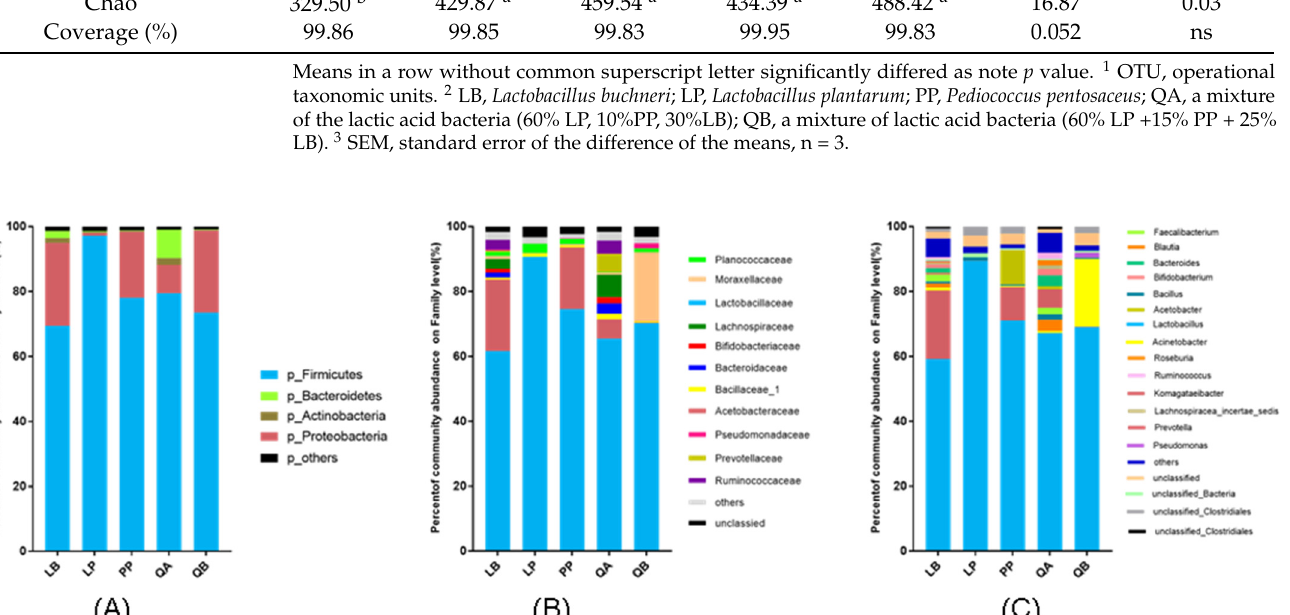
Figure 4. Spearman correlation heatmap of the top tenth of genera and fermentation properties. X and Y axis are environmental factors and genus. R in different colors to show, the right side of the legend is the color range of different p values. LA, lactic acid; AA, acetic acid; PA, propionic acid; NH 3 -N, ammonia nitrogen; ADF, acid detergent fiber; WSC, water-soluble carbohydrates; FAest, ester-linked ferulic acid; FM, fresh matter; NDF, neutral detergent fiber; NGR, ratio of non-glucogenic to gluco- genic acids; pCAest,ester-linked p -comauric acid. 3.4. In Vitro Degradability and Kinetic Gas Production of 60 Days Ensiling Whole Corn Silage Table 5 showed the in vitro degradability and kinetic gas production of 60 day ensi- laged whole corn silage. QA presented higher 48 h, 96 h IVDMD, 48 h INVDFD and 48 h gas production than other groups ( p < 0.01). Regarding gas production kinetics, the high- est asymptotic gas production (A) and sharpness parameter determining the curve shape of the cumulative gas production (B) was noticed in QA and QB treated silage, respec- tively. Gas composition (e.g., H 2 , CH 4 , and CO 2 ) was listed in Table 5 and the lowest